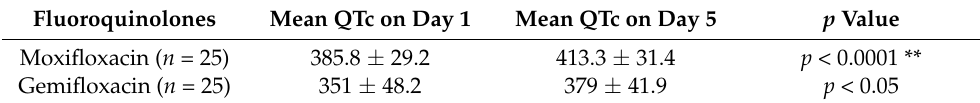
Table 5. Baseline QTc (ms) and QTc (ms) on day 5th in Moxifloxacin and Gemifloxacin groups.